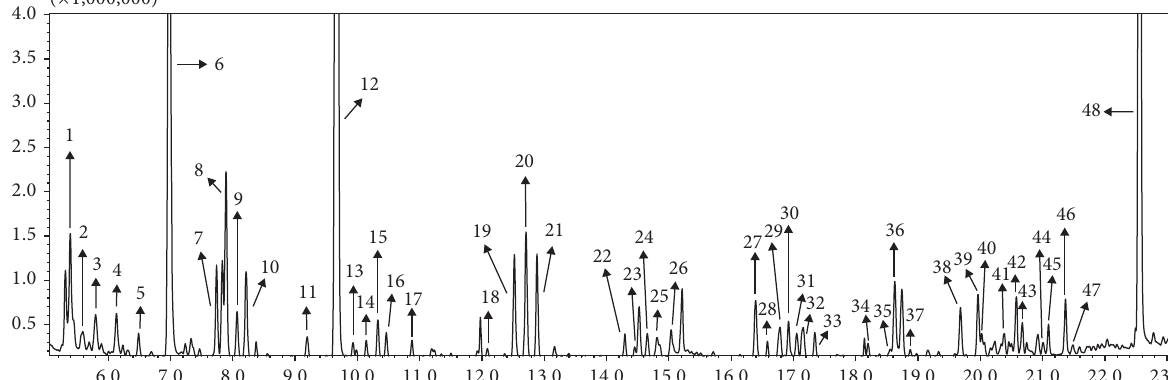
Figure 2: Representative gas chromatography-mass spectrometry (GC-MS) chromatogram of identified volatile compounds from wheat beers. (1) phosphorous acid, (2) tetrachloroethylene, (3) 1-propanol, (4) 4,6-dimethyldodecane, (5) 3,7-dimethyl-1-octene, (6) 2-methyl-1- propanol, (7) 2,4-diethyl-1-heptanol, (8) isoamyl acetate, (9) 1,2-dimethylbenzene, (10) 1,2-dimethylbenzene, (11)